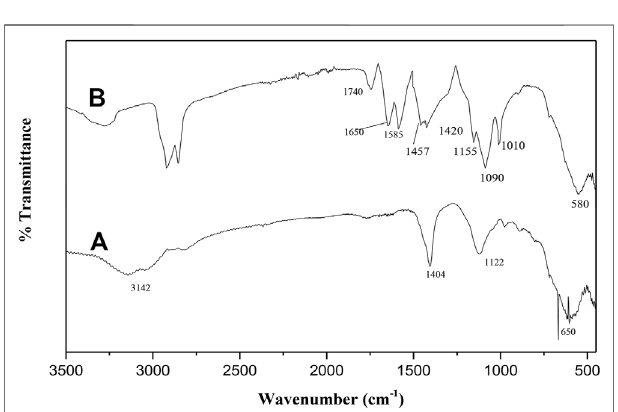
FIGURE 2 | FTIR spectra of (A) magnetic nanoparticles (MNPs) and (B) magnetic chitosan (MC).